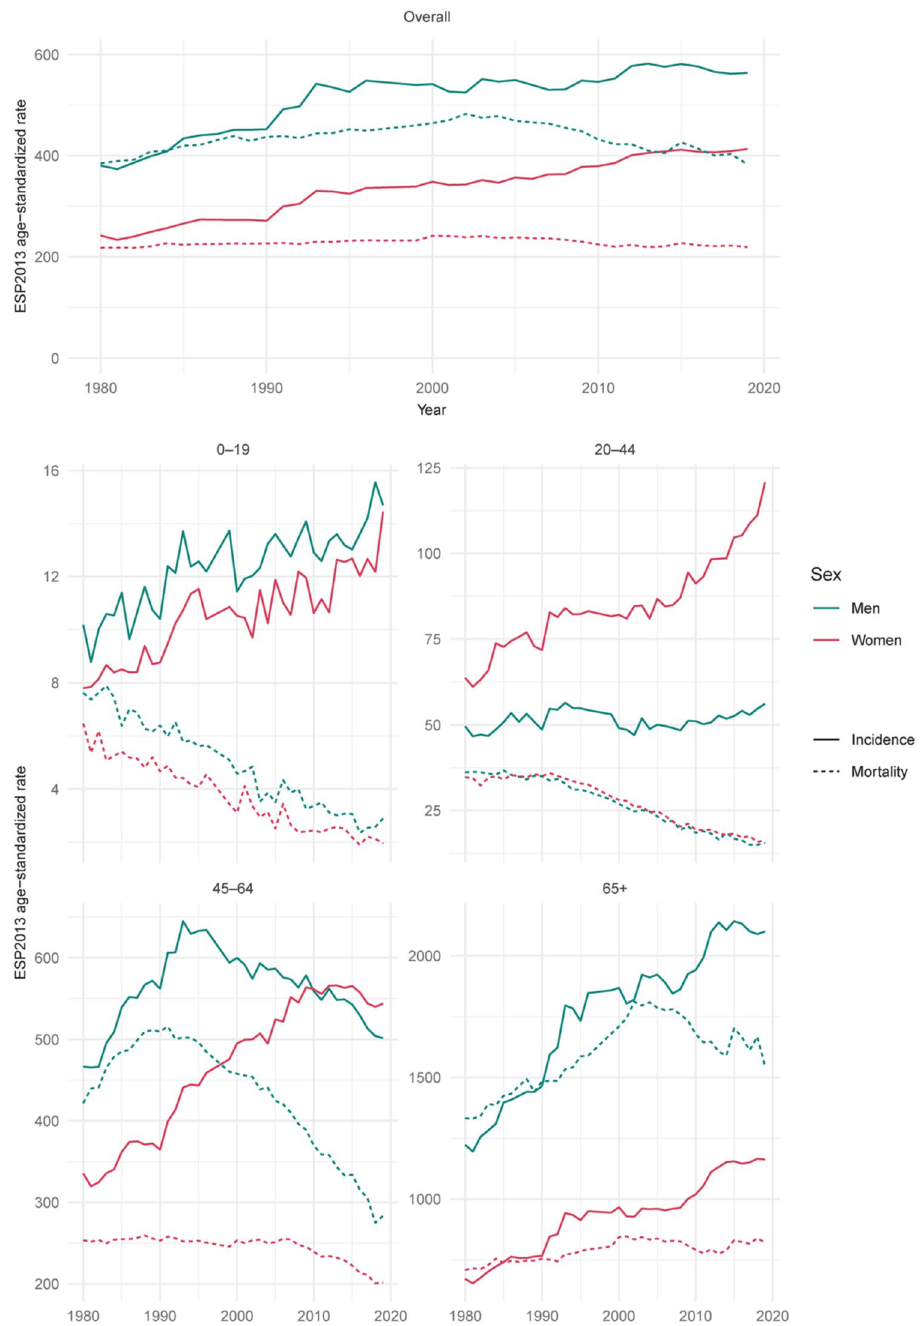
Figure 3. Age-standardized (ESP2013) incidence and mortality rates’ per 100,000 time trends, overall and by age group, by sex—Poland,